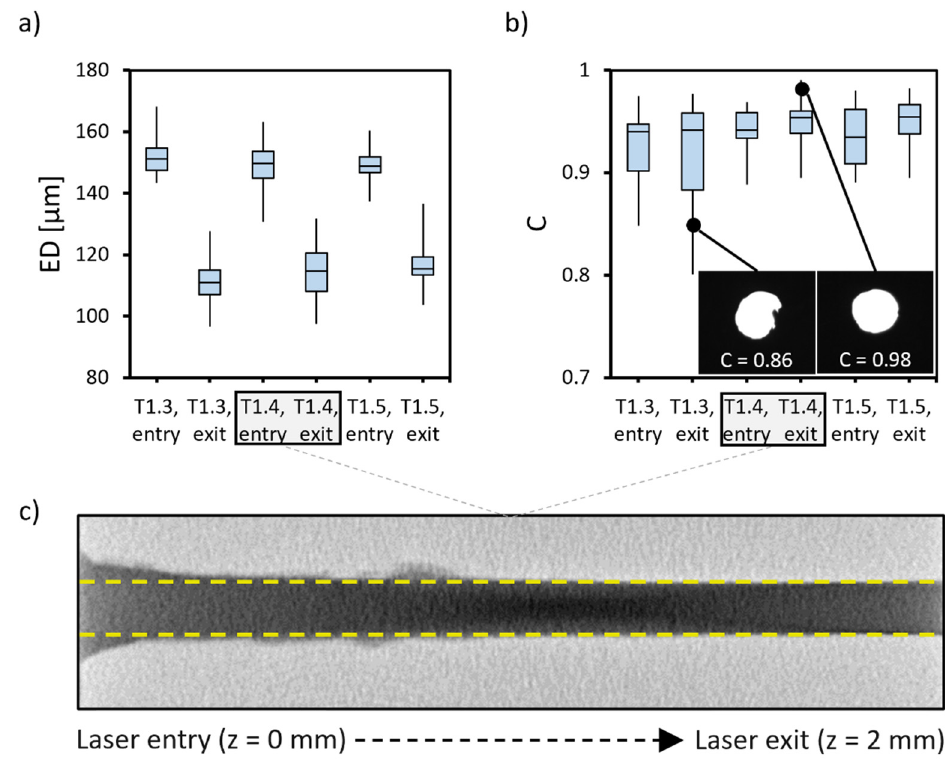
Figure 3. Boxplots for a laser output energy of 1.0 J showing ( a ) the obtained EDs of laser drilled lumens at the laser entry and exit sides for different pulse durations (1.3, 1.4, and 1.5 ms), and ( b ) the C values for the same laser drilled lumens. The boxes in the boxplots display (from top to bottom) the upper quartile, the median and the lower quartile. Whiskers indicate the minima and maxima ( n > 22 for all conditions) and insets show examples of BF microscopy images obtained and the corresponding results. ( c ) A cross-section by μ CT scanning of a lumen percussion laser drilled with energy 1.0 J and pulse duration 1.4 ms. The yellow dashed lines indicate the width at the laser exit side, demonstrating the nearly straight microlumen and substantial widening near the laser entry side.